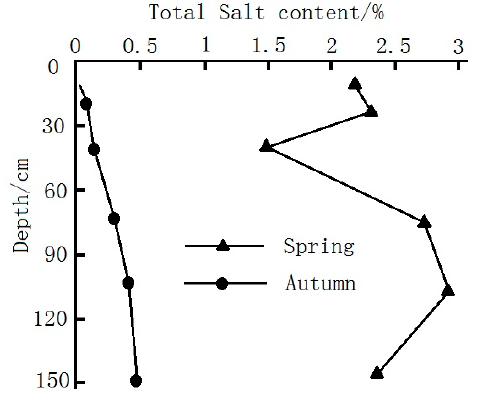
Figure 7. Total salt content at different sampling depths.